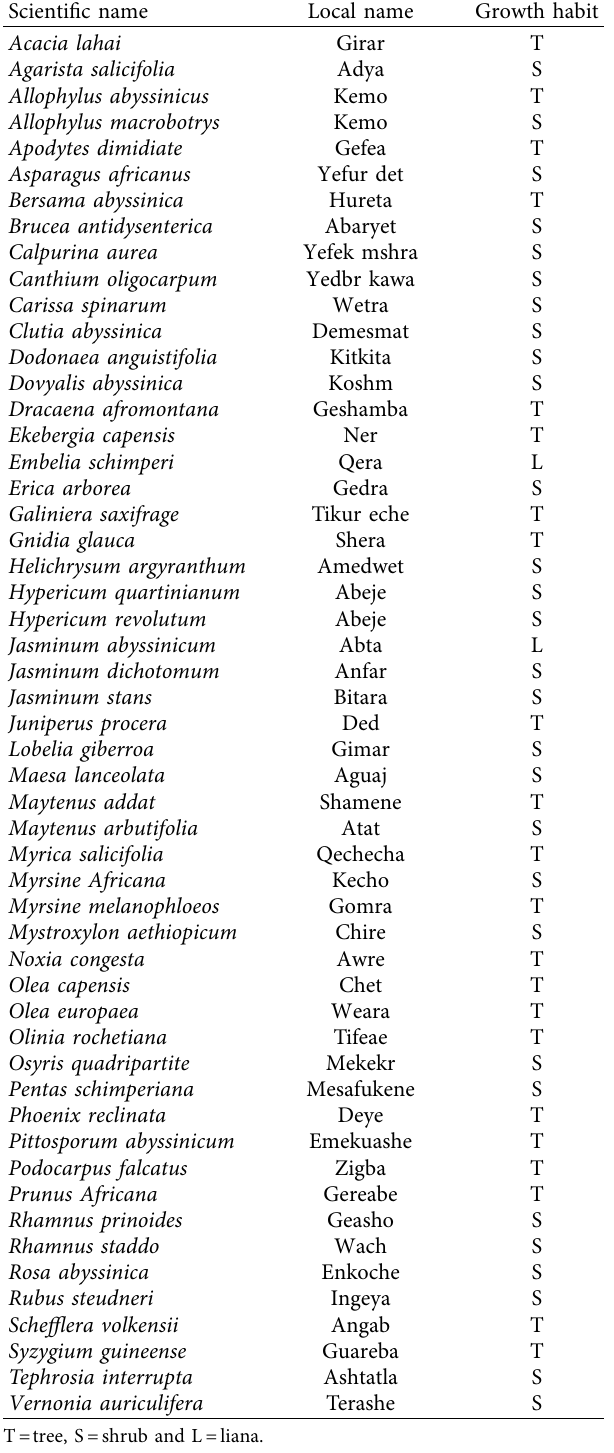
Table 1: Species list recorded with Gurage local name, language, and growth habit.